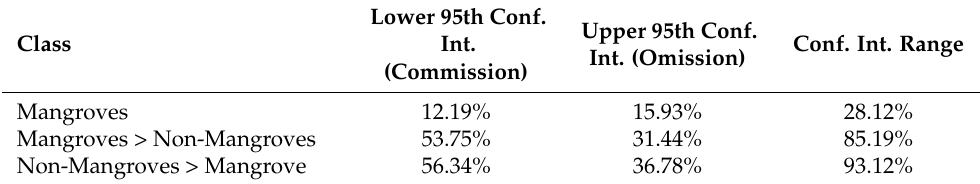
Figure 11. Accuracy of the individual classes using the F1-score with an increasing number of accuracy samples. Table 9. The upper and lower 95th confidence intervals (i.e., omission and commission) for each of the classes, which can be used with Equations (1) and (2) to calculate the extent confidence intervals for any region of the GMW